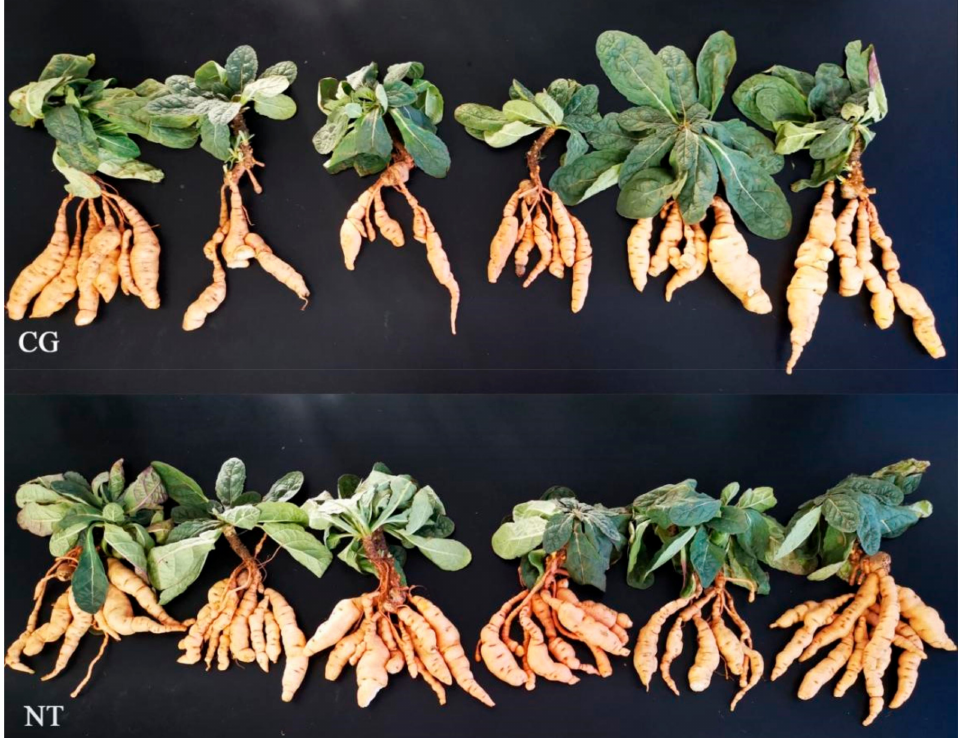
Figure 1. Mature NAA-treated R. glutinosa plants and control plants as examples showing their tuberous